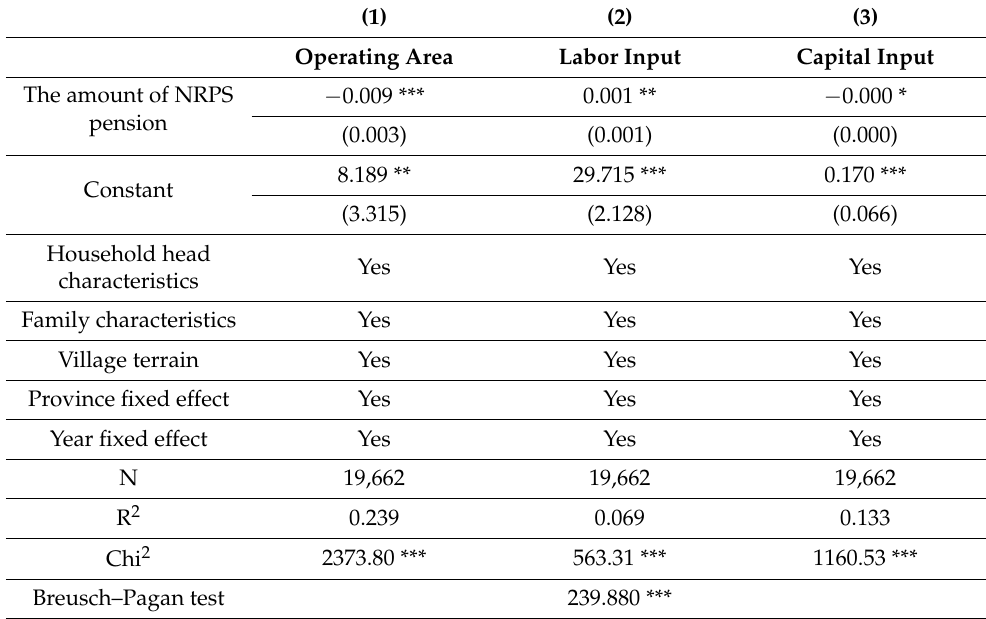
Table 4. Robustness test: Replacing key independent